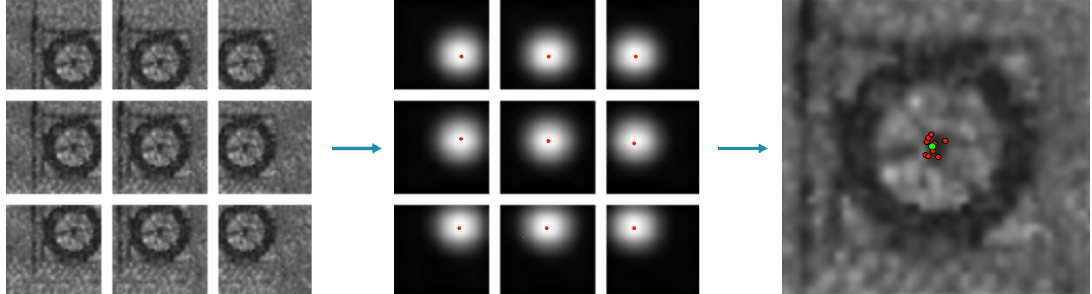
Figure 6. Visualization of the localization workflow, starting with the different sliding window positions ( left ) of which the corresponding activation maps are extracted from the last pooling layer ( middle ). The weighted activation centers are depicted by the red points and are projected onto the original image ( right ). The center of the manhole cover is computed by the weighted average of these activation centers and is indicated by the green